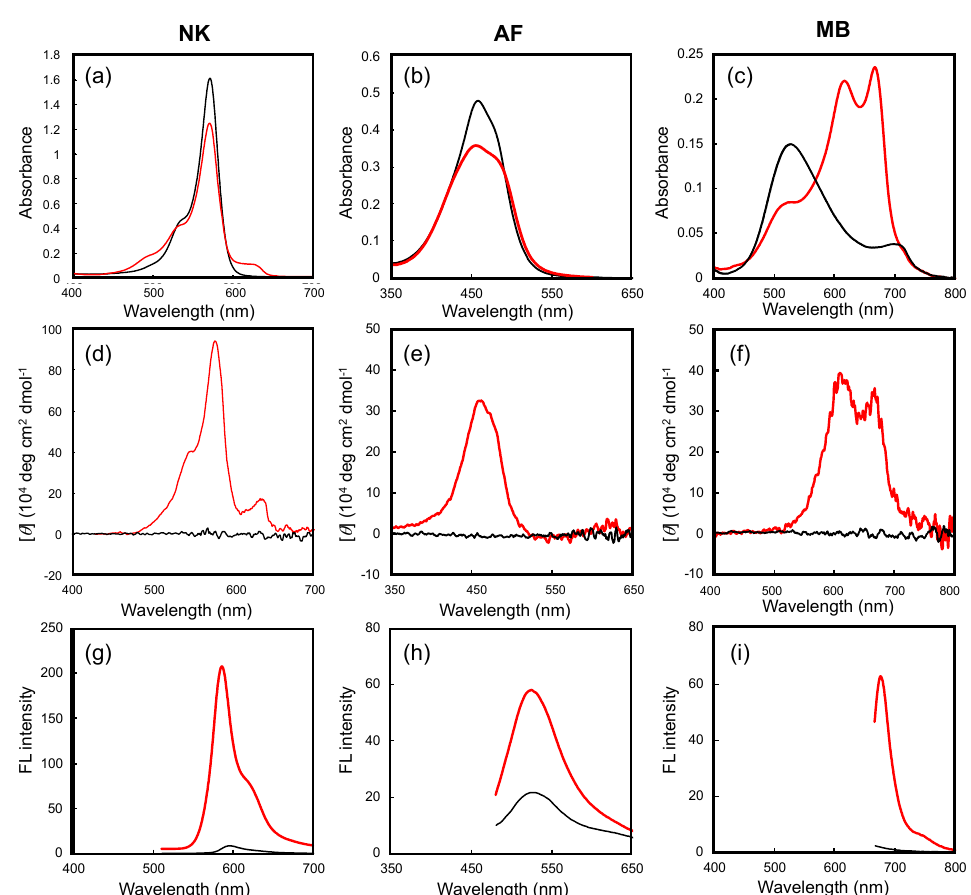
Figure 3. ( a–c ) UV-visible, ( d–f ) CD, and ( g–i ) FL spectra of dyes in the presence and absence of G -CA aggregates at 25 ◦ C. Figure 3. ( a – c ) UV ‐ visible, ( d – f ) CD, and ( g–i ) FL spectra of dyes in the presence and absence of G ‐ CA aggregates at 25 °C. Solvent, toluene; concentrations: 0.05 mM (dye), 0.75 mM ( G ‐ CA), 0.5 mM Solvent, toluene; concentrations: 0.05 mM (dye), 0.75 mM ( G -CA), 0.5 mM (TEA). The red and black traces correspond (TEA). The red and black traces correspond to the presence and absence of G ‐ CA, respectively. to the presence and absence of G -CA, respectively. The FL spectra in ( g–i ) were obtained by excitation at 500, 470, and The FL spectra in ( g – i ) were obtained by excitation at 500, 470, and 650 nm, respectively. 650 nm,